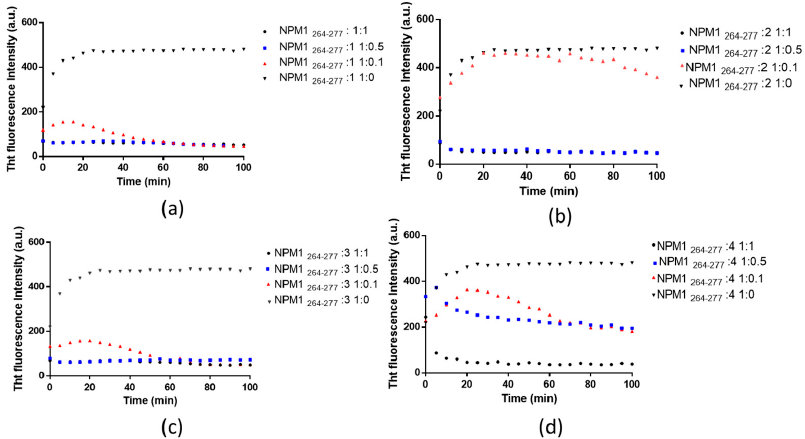
Figure 2. Time course of Thioflavin T (ThT) fluorescence emission intensity of NPM1 264–277 upon incubation with different concentrations of ( a ) 1 , ( b ) 2 , ( c ) 3 , ( d ) 4 . The peptide alone is reported as a grey triangle. The peptide incubated with the compounds in 1:1, 1:0.5 and 1:0.1 peptide to metal complex molar ratio are reported as a black circle, blue square and red triangle, respectively.